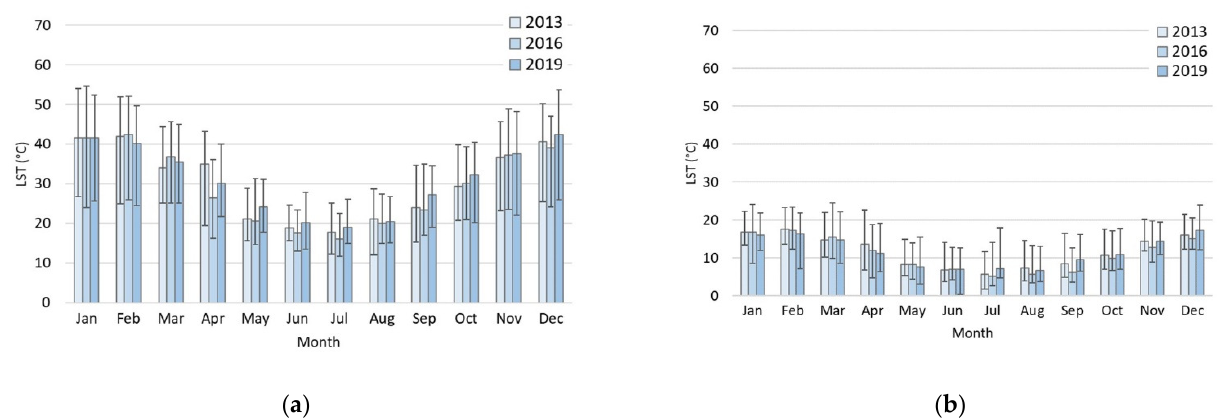
Figure 3. Perth MYD11A2 mean and min/max LST: ( a ) day and ( b ) night.